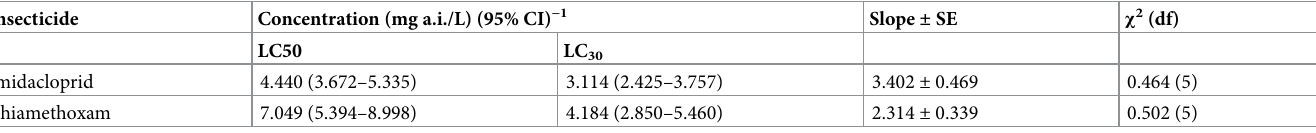
CI, confidence interval; SE = standard